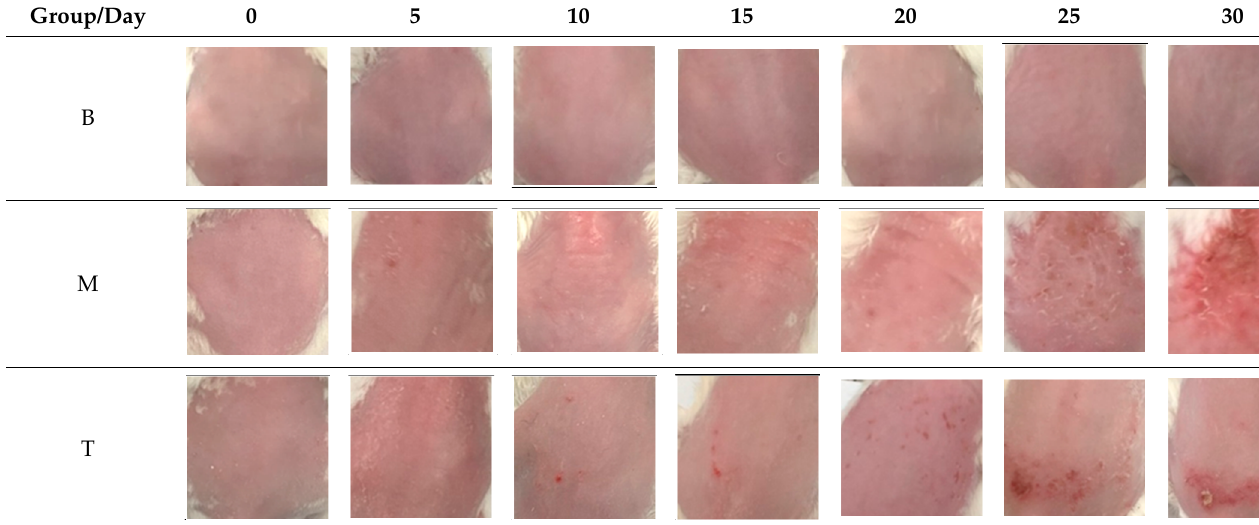
Table 2. Skin status of mice in each group within 30 days.